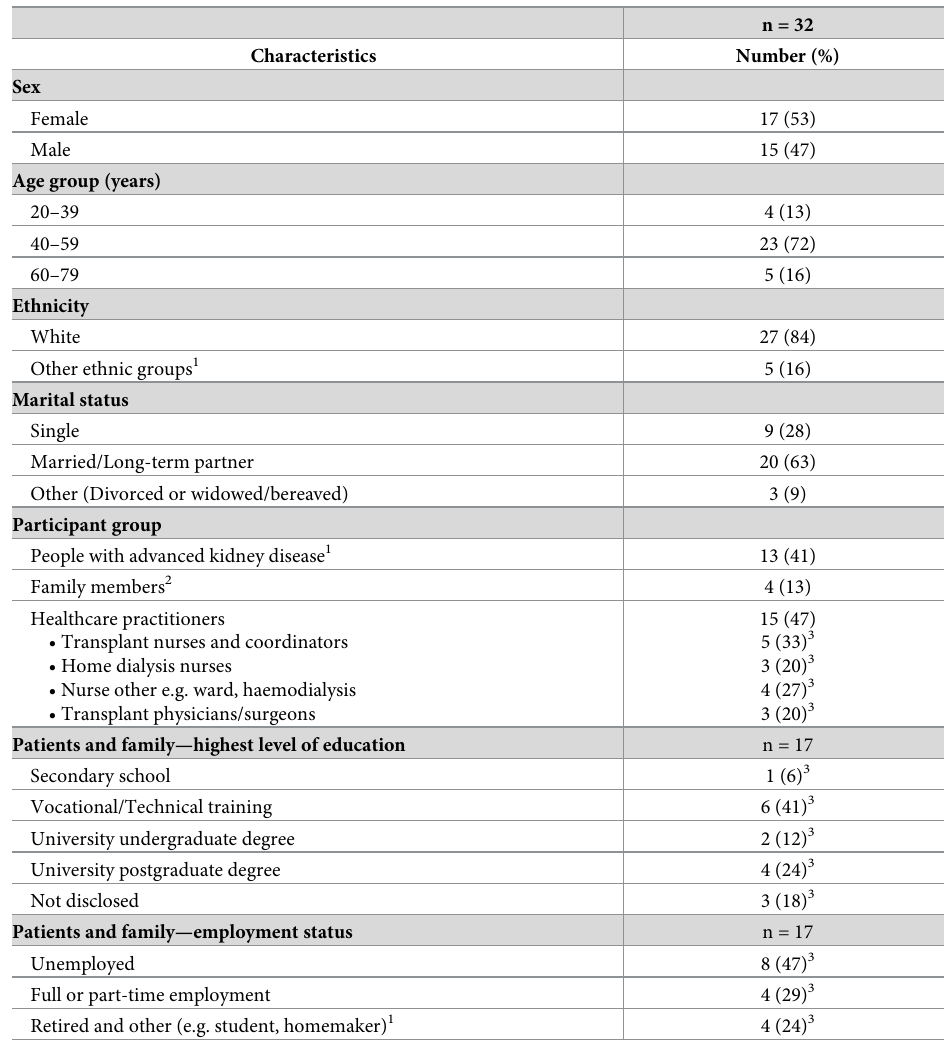
Table 4. Participant